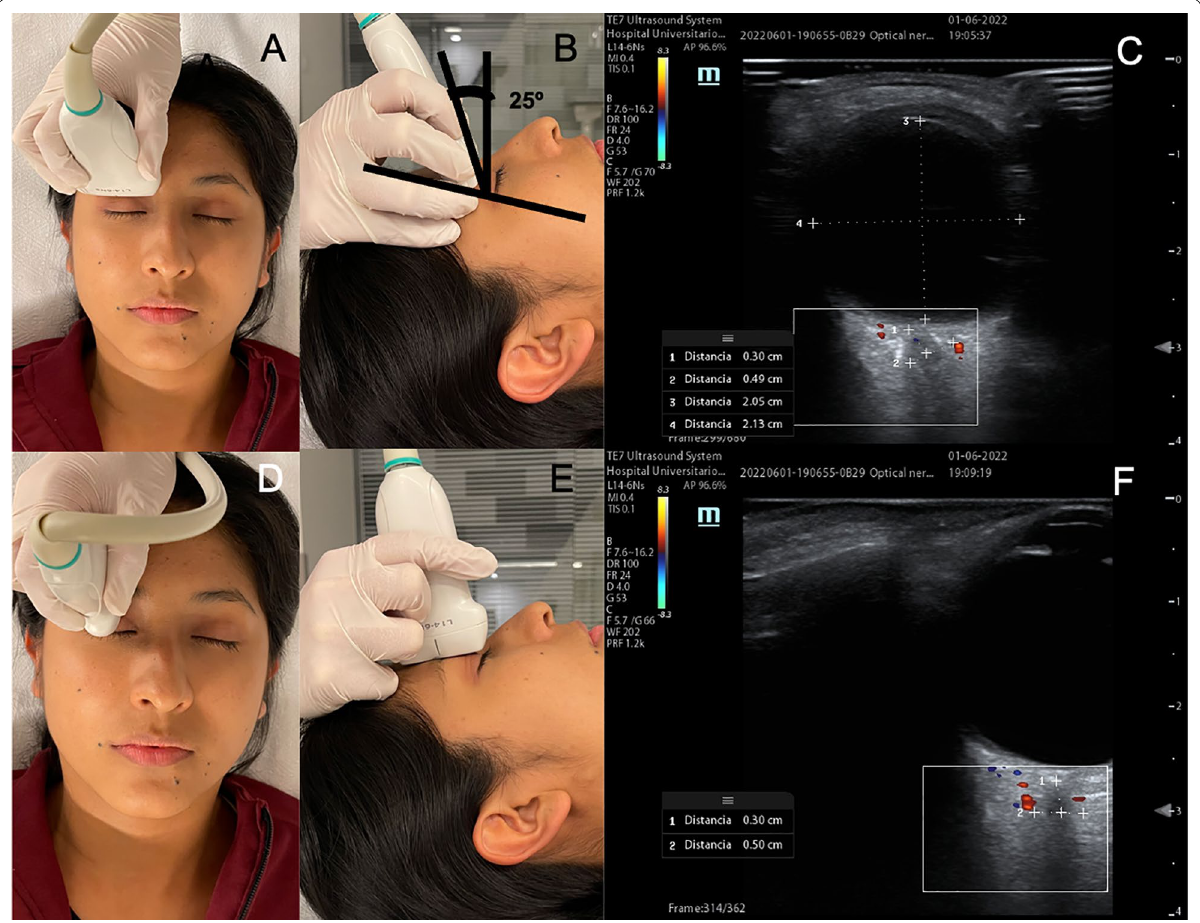
Fig. 1 Ultrasound measurements technique. A – B : The transducer positioned on the transverse axis with an initial angle of 25° and tilted until the optic nerve and the papilla were visualized. C : Optic nerve and papilla with color doppler mode showing the central vessels of the retina, the ciliary vessels and measurement performed using central vessels of the retina direction and landmarks from the ciliary vessels. D – E : The transducer positioned on the vertical axis. F : Optic nerve and papilla with color Doppler mode showing the central vessels of the retina, the ciliary vessels and measurement performed using central vessels of the retina direction and landmarks from the ciliary